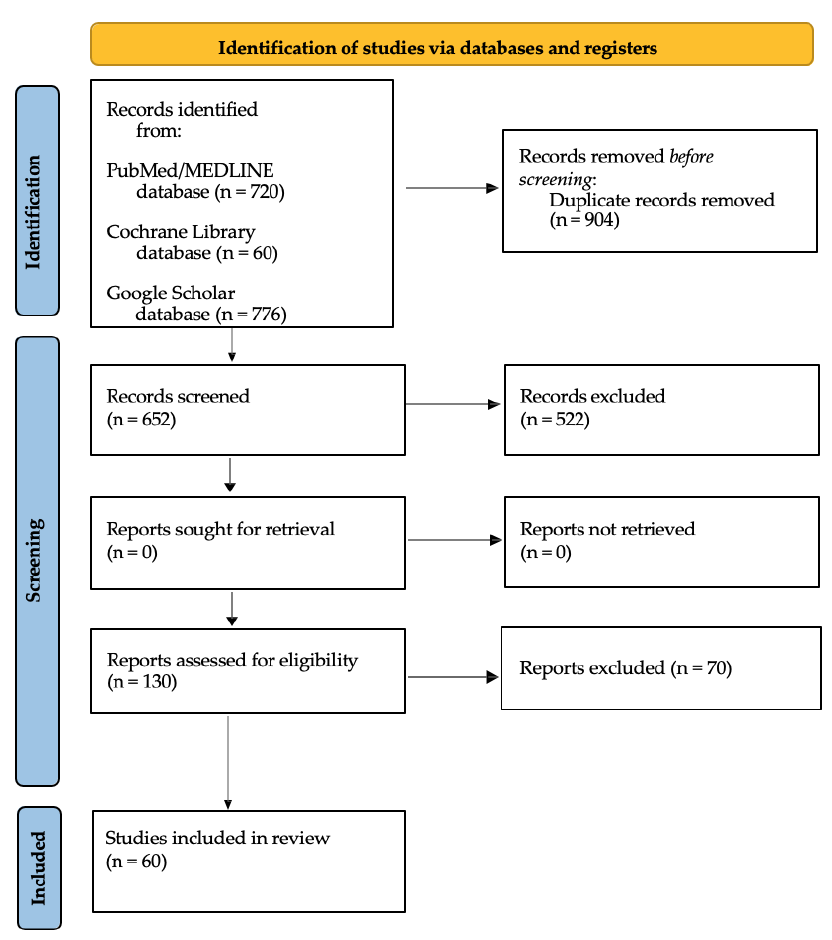
Figure 1. Study selection flowchart. Table 1. Included studies characteristics: source, study participants’ gender and age; treated teeth, extra-alveolar time stay, and extra-alveolar environmental conditions management; IR indication(s), outcomes and follow-up. Abbreviations: y.o., years old; MR, multi-rooted; SR, single-rooted; IR, Intentional